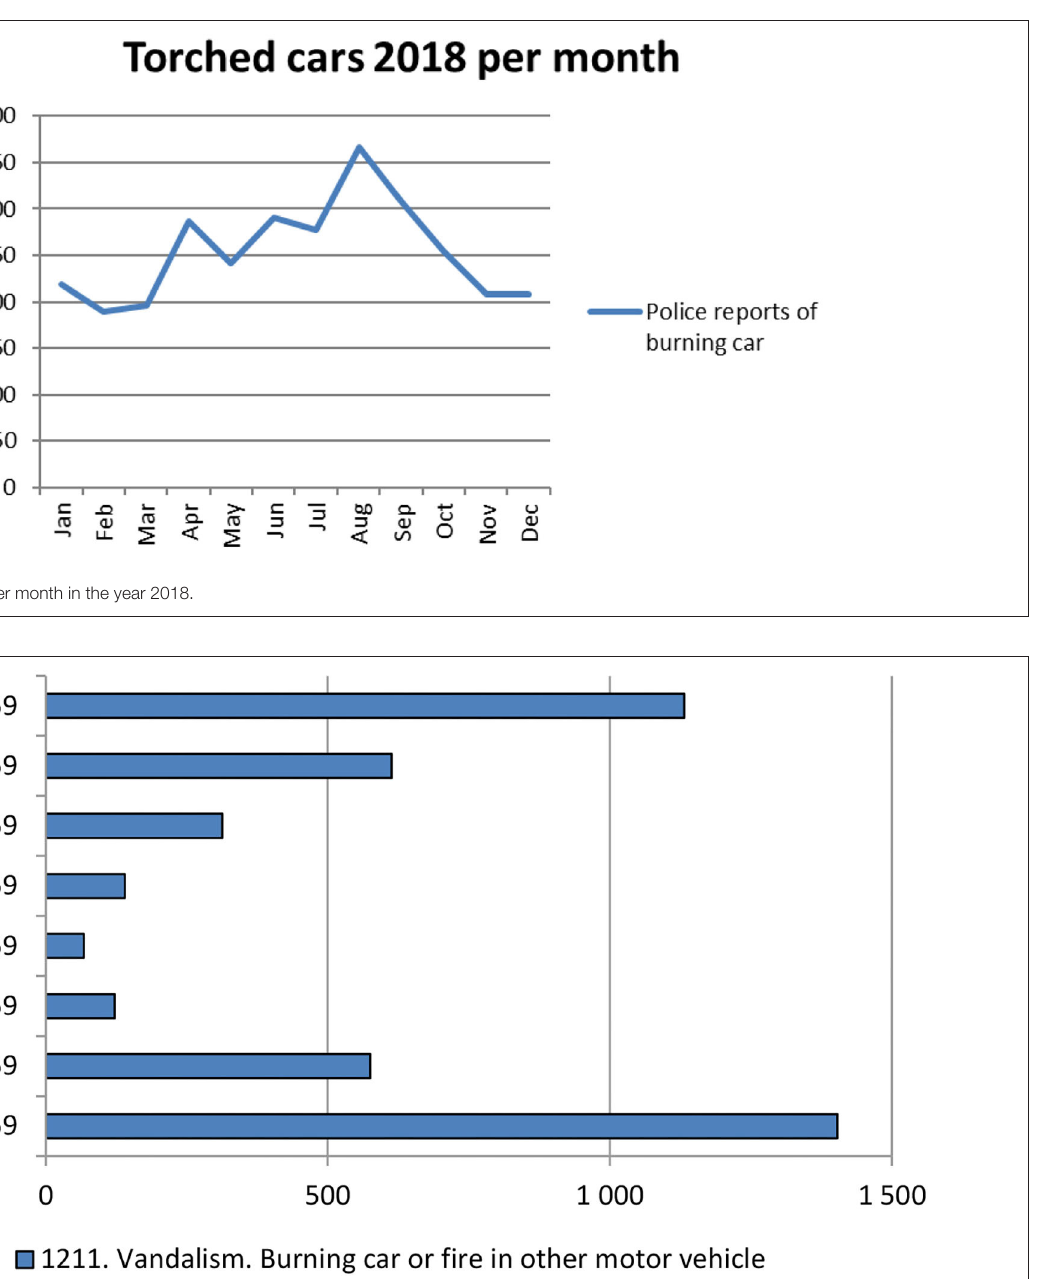
done by simply selecting crime type and police district, and then choosing map and heat map. An example is shown in Figure 3 below, for the city of Helsingborg. For the cities of Malmö and Helsingborg strong concentrations in the deprived neighborhoods labeled as “vulnerable” by the police were noted, while Lund has no such neighborhoods. The maps were delivered to the helicopter crews to give them an indication of where the flying should be